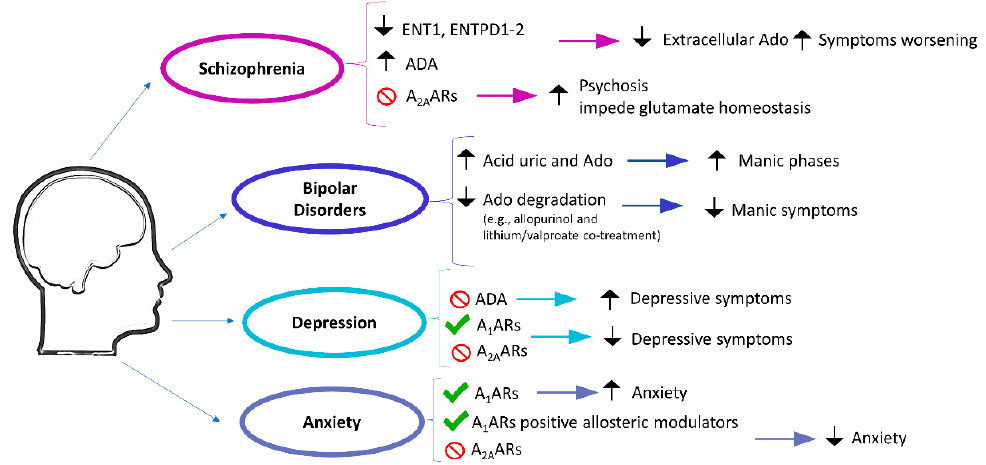
Figure 1. Involvement of adenosinergic system in psychotic and mood disorders. ENT1, equilibrative nucleoside transporter 1; ENTPD, ectonucleoside triphosphate diphosphohydrolase; ADA, adenosine deaminase. Green check mark, activation; red prohibition sign, blockade; upward arrow, increase; downward arrow, decrease.